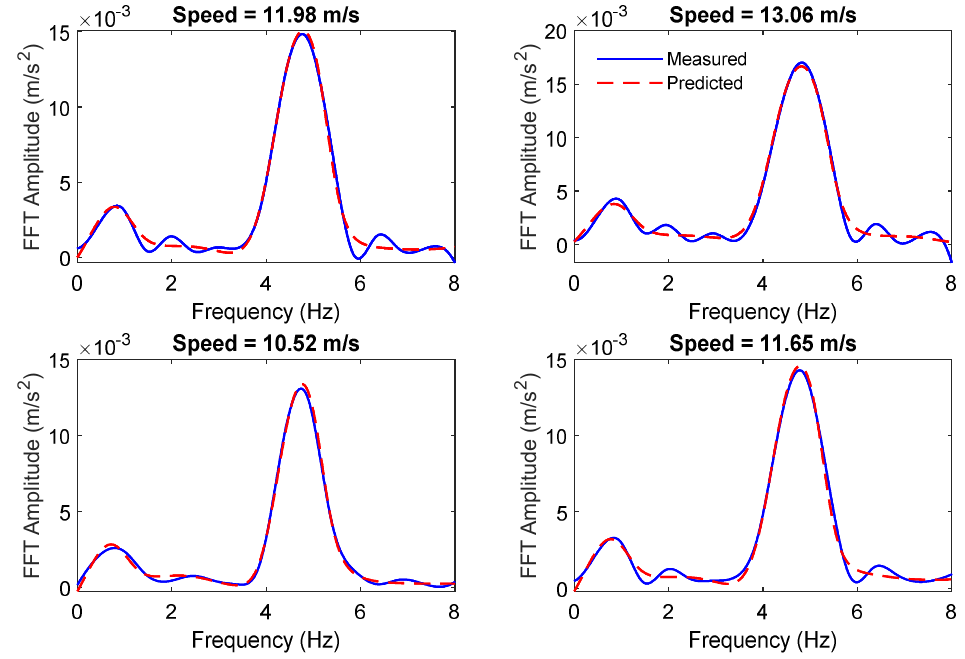
Figure 11. The comparison of the predicted and measured vehicle FFT responses over the healthy bridge.